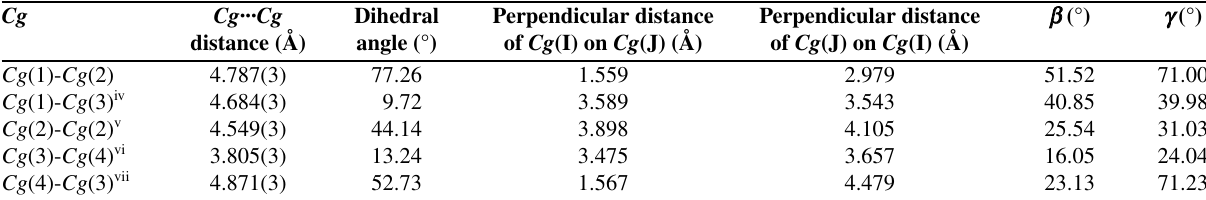
Table 4 Parameters between the planes for the complex Cg Cg ··· Cg Dihedral Perpendicular distance Perpendicular distance